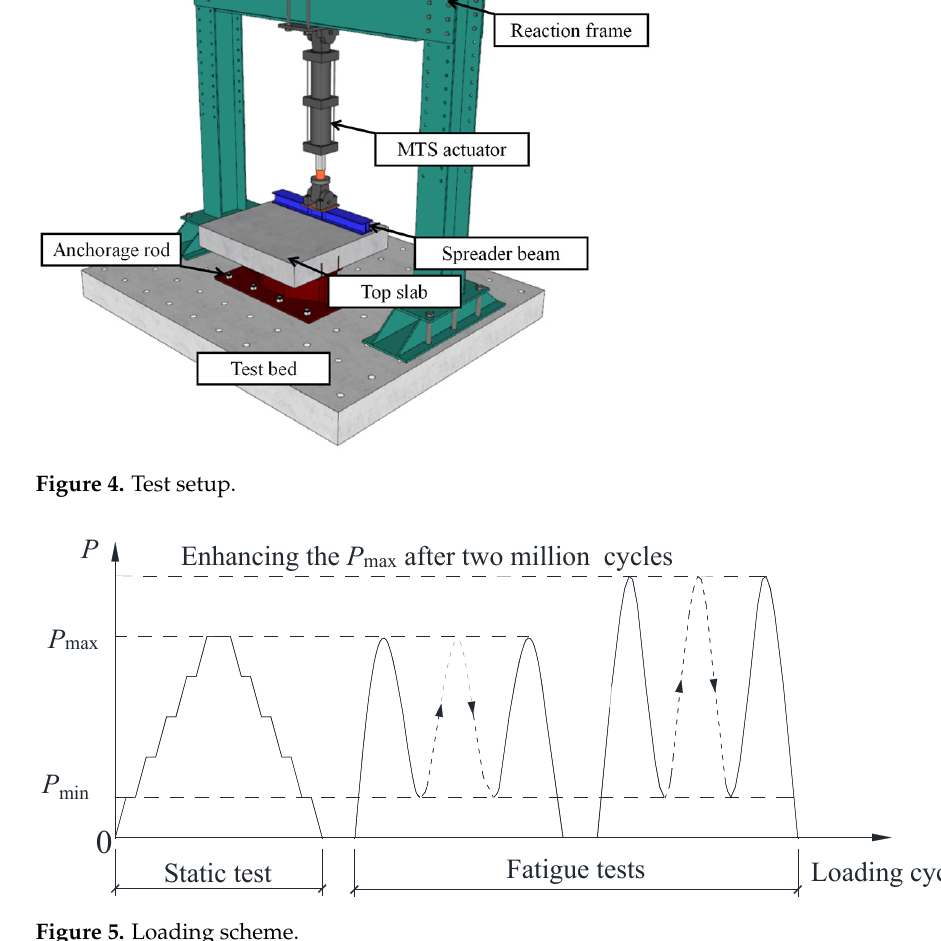
Figure 5. Loading scheme. Figure 5. Loading